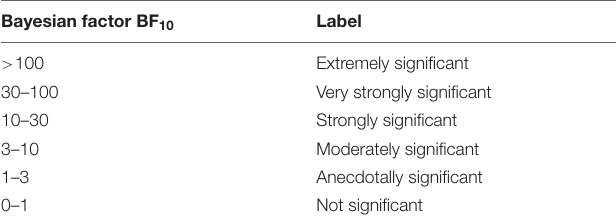
TABLE 2 | Interpretation of Bayesian factors (BF 10